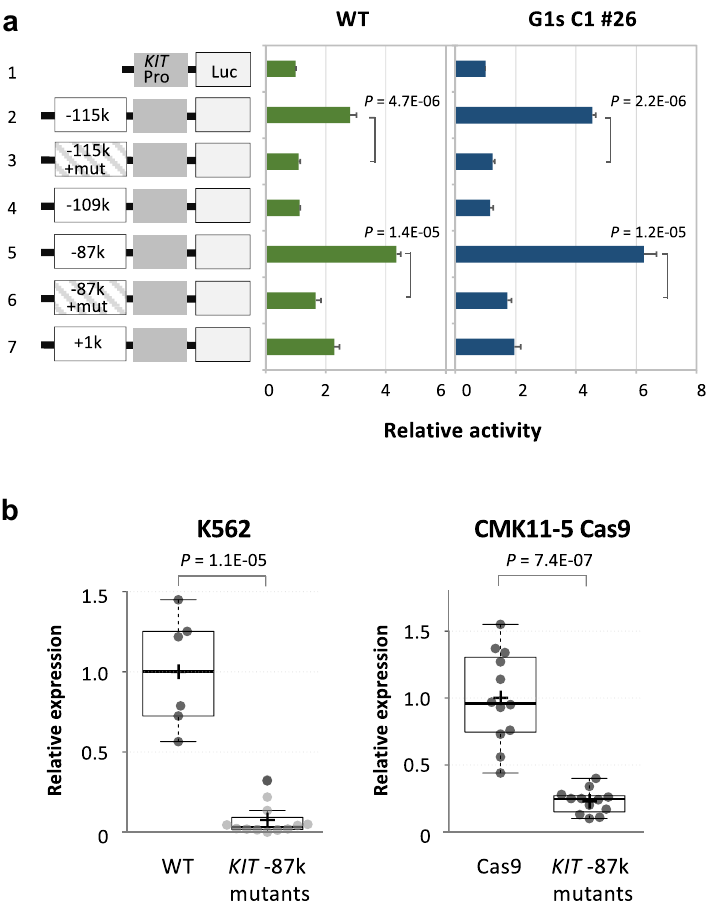
Figure 4. Enhancer/silencer assay of KIT and genome editing of GATA site in KIT − 87 k region. ( a ) Schematic diagram of reporter constructs and results of luciferase assay. The green solid bar indicates K562-WT and the blue bar K562-G1s C1 #26. The horizontal axis represents a relative activity with each value of the KIT promoter vector set at 1. The numbers on the vertical axis indicate the introduced vectors, whose schematic diagram are attached next to them. 1; KIT promoter vector, 2; − 115 kb, 3; − 115 kb with mutated GATA site, 4; − 109 kb, 5; − 87 kb, 6; − 87 kb with mutated GATA site, 7; + 1 kb region. Results are averages of three independent experiments. Error bars represent standard deviation. The P -values of the two-side t-test were given. ( b ) Expression levels of KIT in the KIT -87 kb GATA site mutants. Only the − 87 k homozygous mutants were selected for quantification of KIT expression. (Left) a comparison of six K562-WT single clones and twelve KIT − 87 kb mutants. Each sample mean is represented by a cross. Since most of the − 87 kb mutants were outside the quantitative range, their dots are shown in gray. (Right) twelve CMK11-5 Cas9 single clones and twelve KIT − 87 kb mutants. The vertical axis shows the relative value of the K562-WT single clones or CMK11-5 Cas9 single clones set to 1. The P -values of the Mann–Whitney U test were